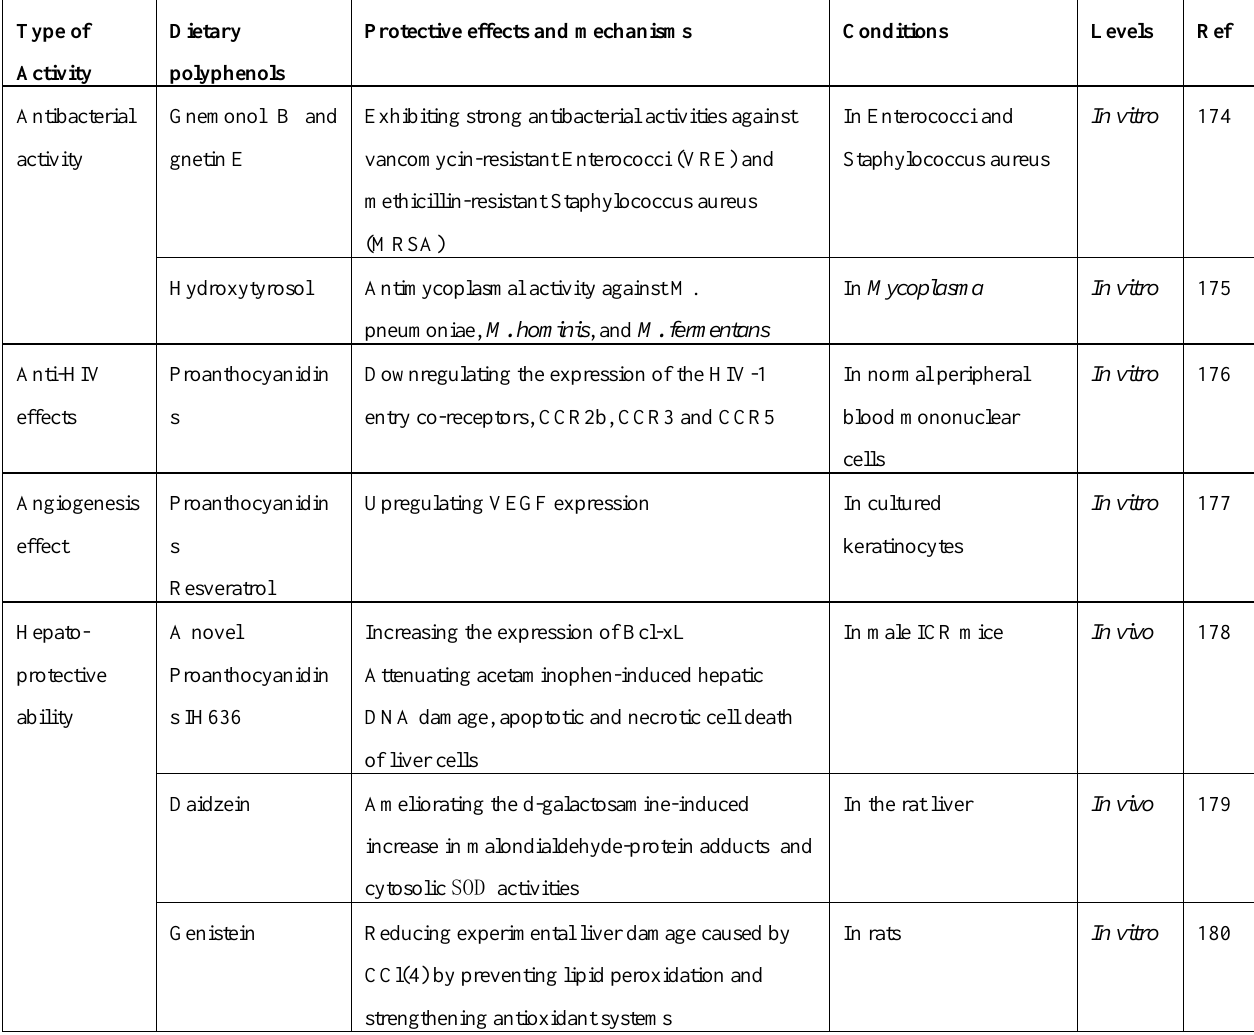
Table 11. Other bioactive effects of dietary